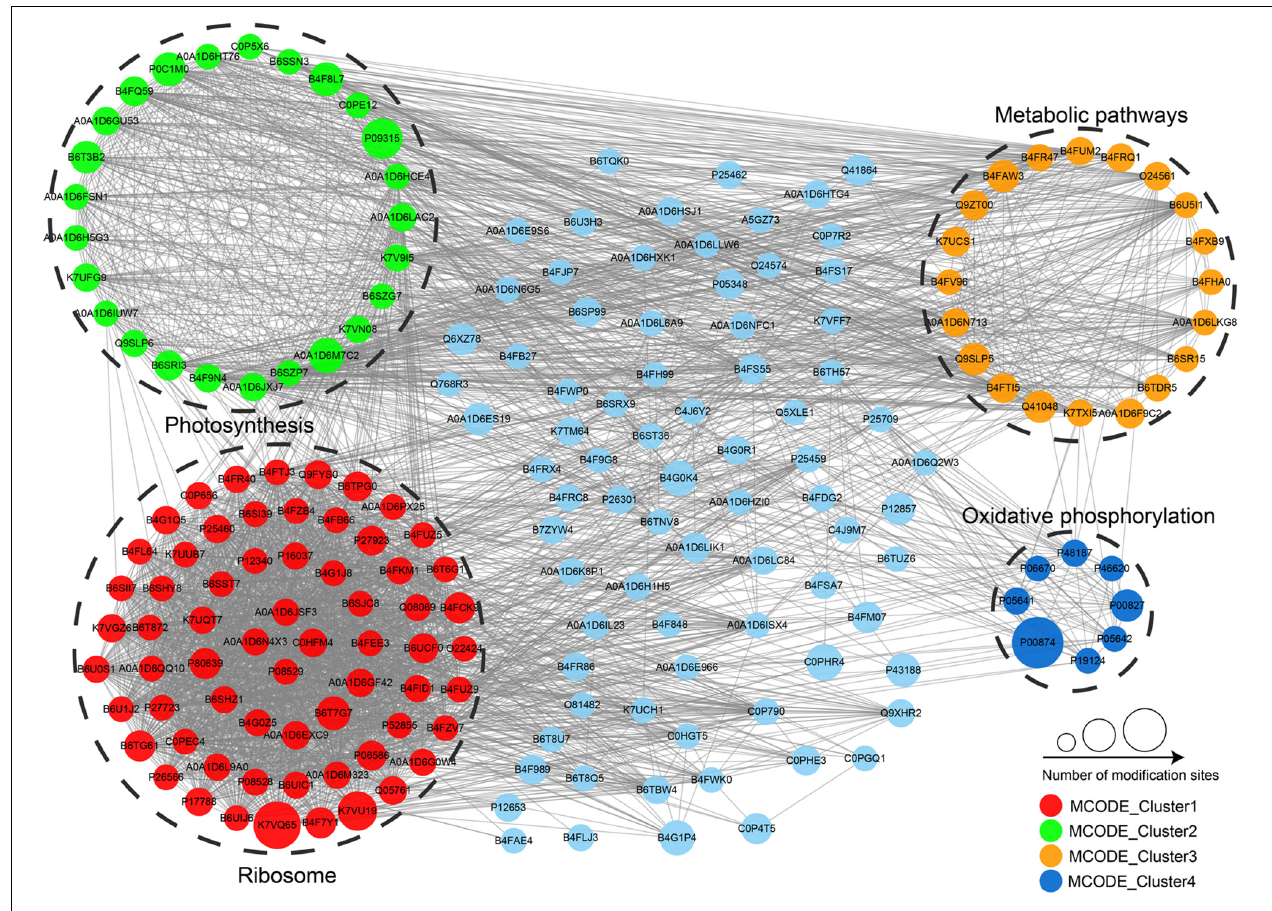
FIGURE 7 | Interaction networks of the identified malonylproteins in maize.